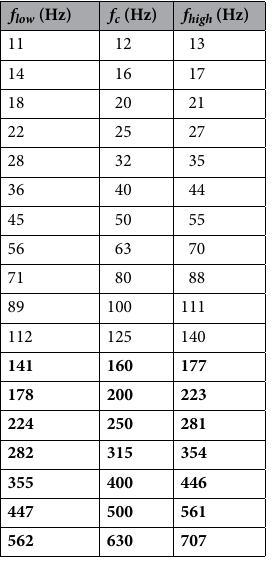
Table 4. 1/3-Octave bands. Bands used in this work are in